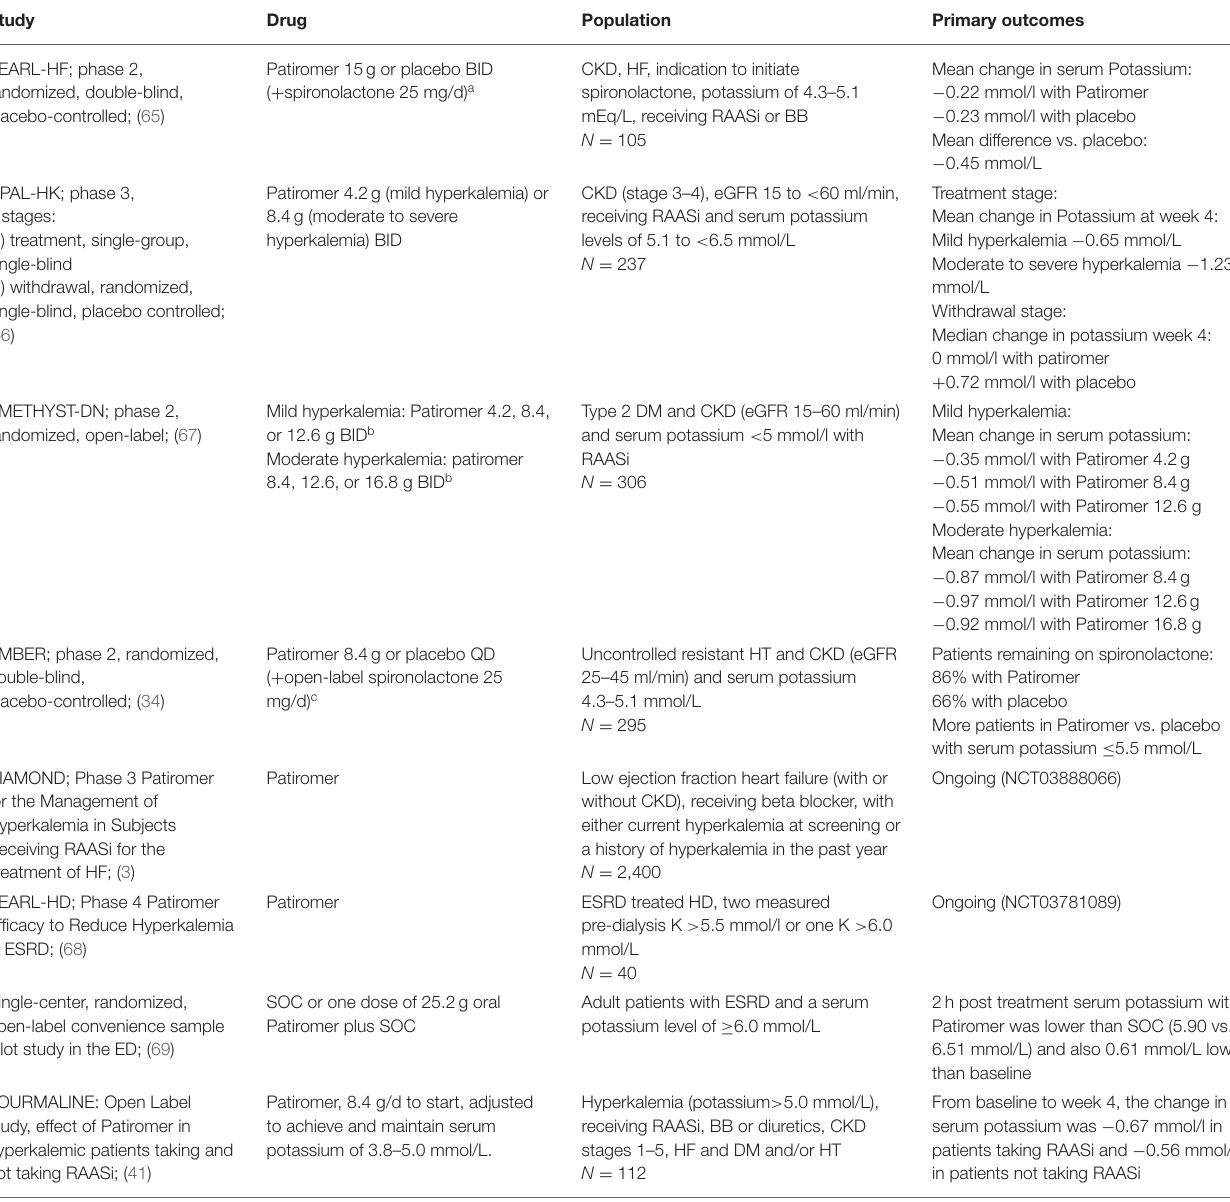
TABLE 3 | Clinical studies of patiromer (54). Study Drug Population Primary outcomes PEARL-HF; phase 2, randomized, double-blind, placebo-controlled; (65)